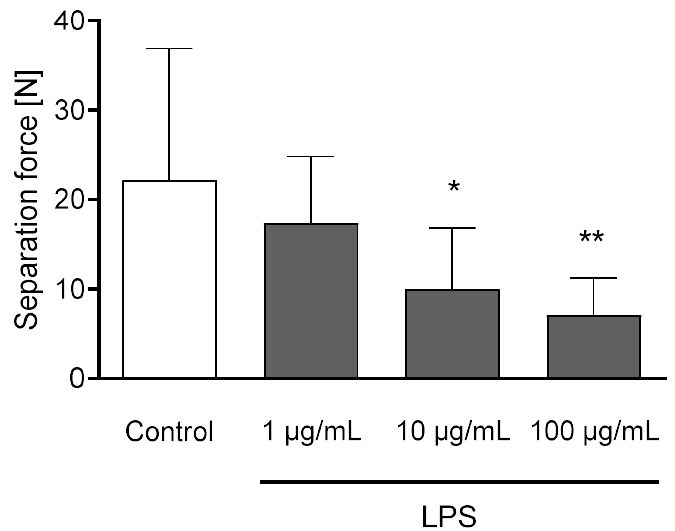
Figure 6. Separation force [N] of untreated explants (Control) and explants incubated with 1, 10, and 100 µg/mL LPS) for 24 h. n = 12 explants. Error bars present standard deviation. * Asterisks indicate significant differences: * p < 0.05, ** p < 0.01.